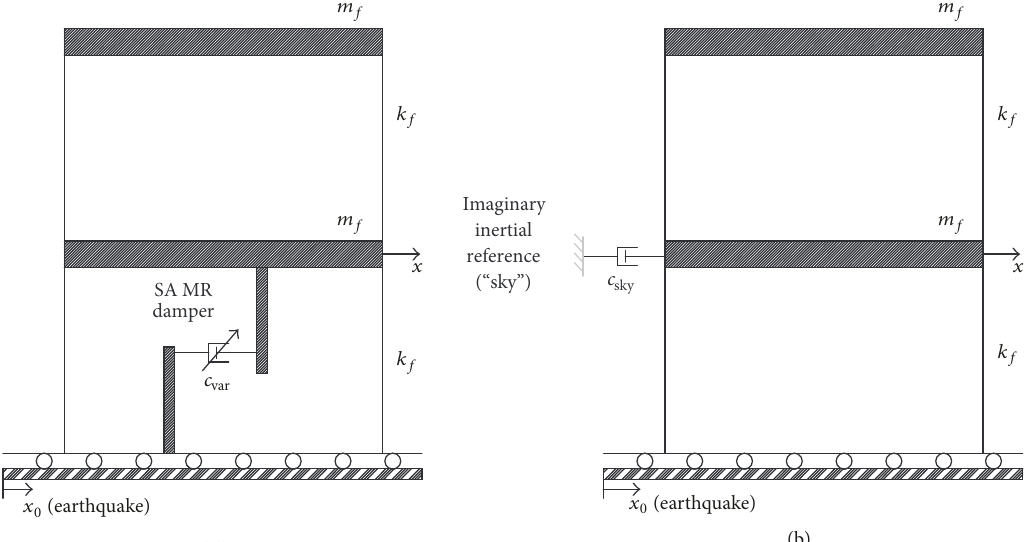
Figure 10: Sky-hook based semiactive control as designed for the case study structure (a). Sky-hook passive damping scheme taken as a reference to be